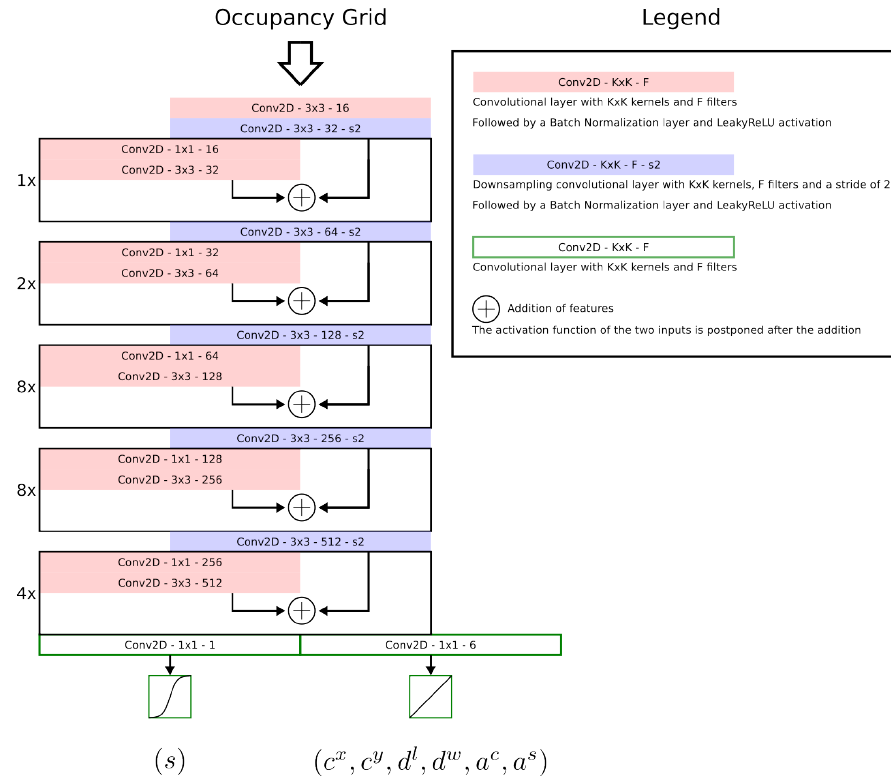
Figure A3. Architecture of GRID-YOLOv3 containing 10,158,679 trainable